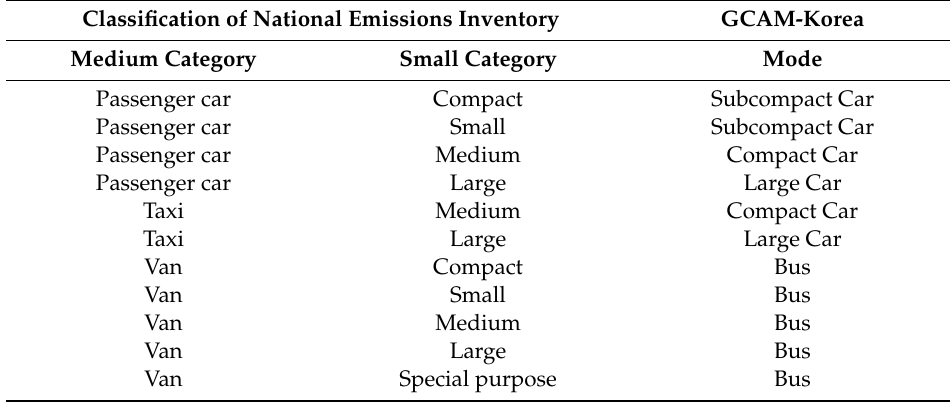
Table A1. The Mapping of Vehicle Type in the National Inventory to Vehicle Mode in